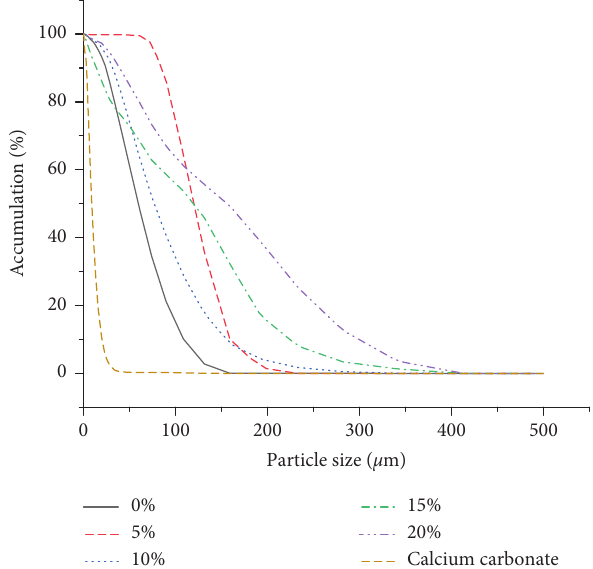
Figure 9: Grain size distributions of red clay samples doped with different contents of calcium carbonate.